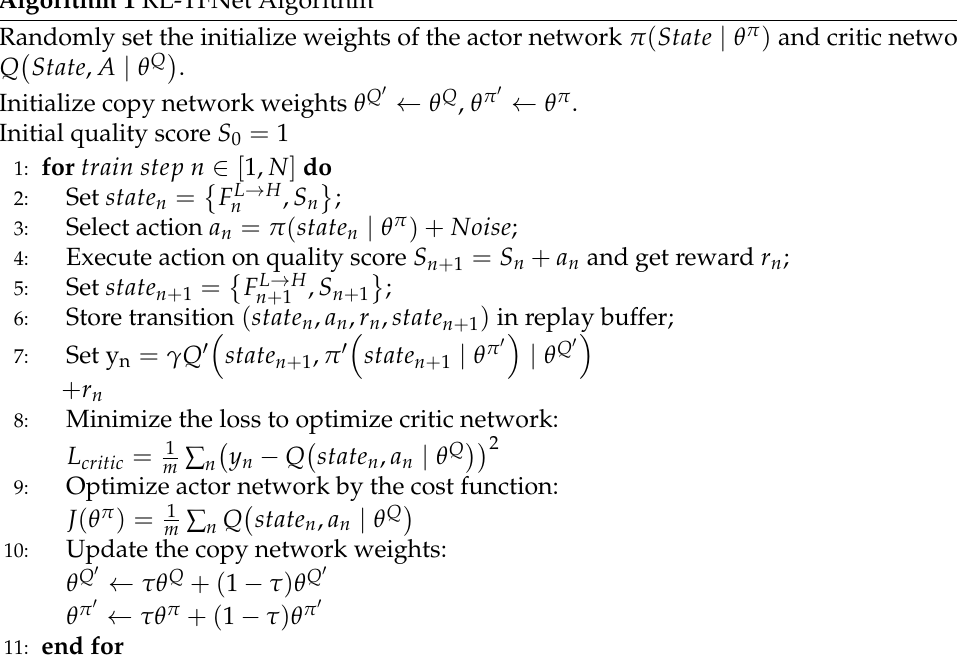
Algorithm 1 RL-TFNet